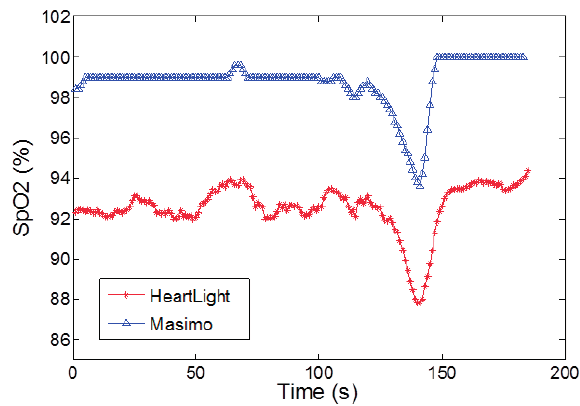
Figure 8. Comparison of the SpO2 outputs of the CMOS sensor and a Masimo Radical-7 in reflectance mode for a breath hold and release